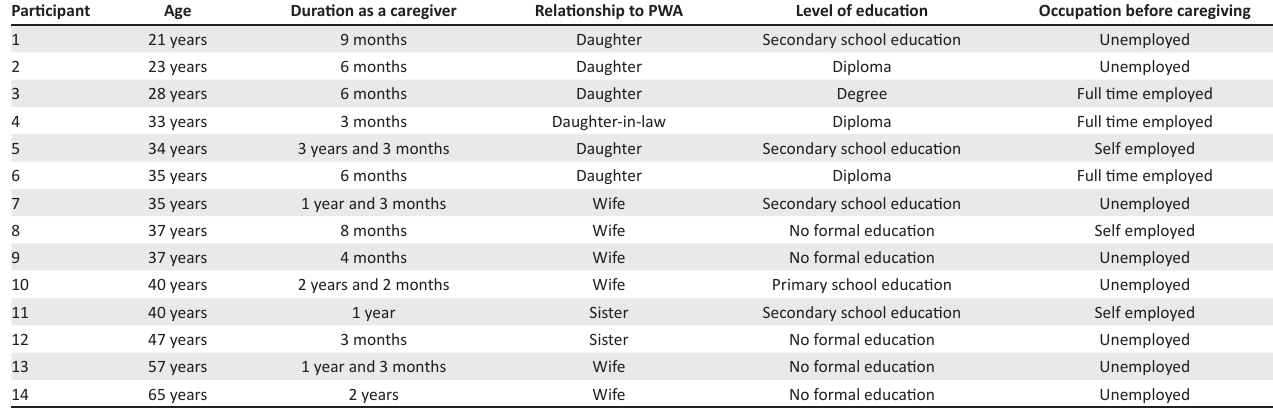
TABLE 1: Research participants: Demographic